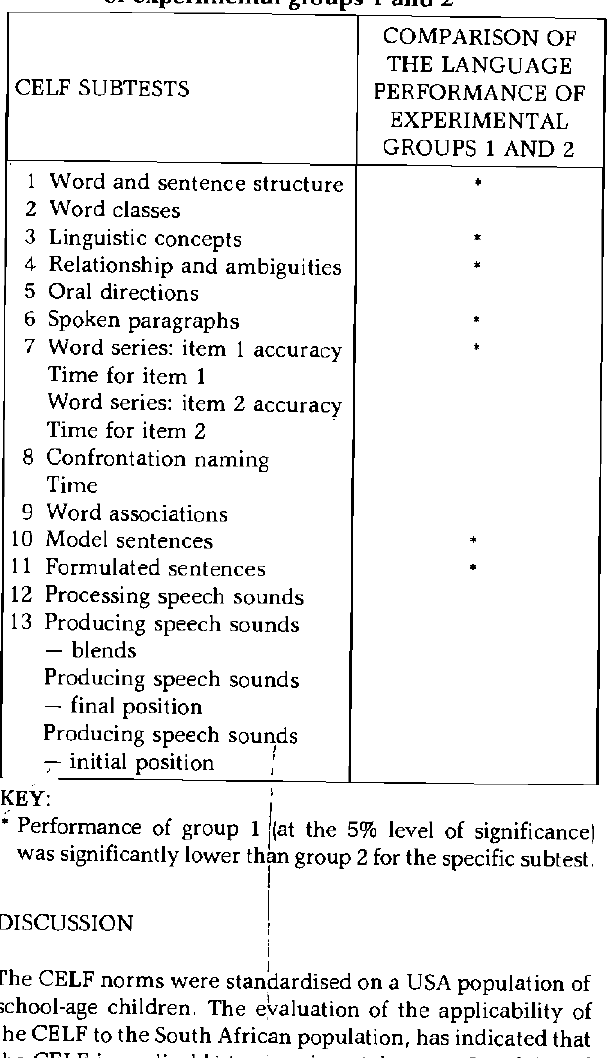
Table 4: The comparison of the language performance of experimental groups 1 and 2